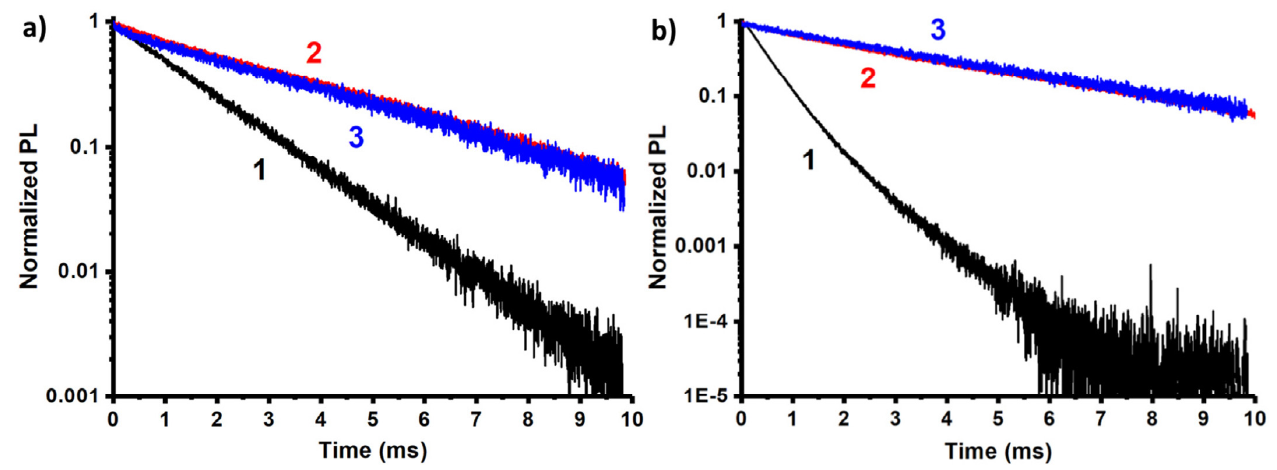
Figure 4. Luminescence decay curves for [Eu( L ) x ] (a) and PSS-[Eu( L ) x ], (b) in logarithmic scale (L = a (1), b (2), c (3)) under the excitation of corresponding wavelengths (Table